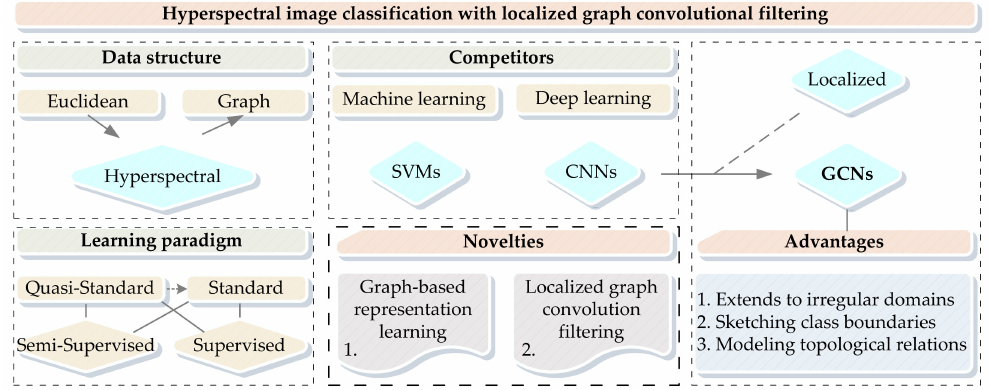
Figure 1. The overview of hyperspectral image (HSI) classification with localized graph convolutional network